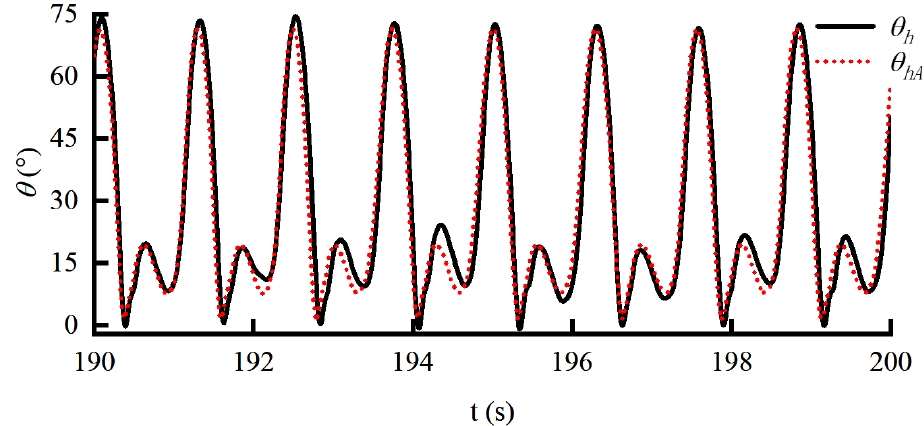
Figure 14. The angle curve predicted by AO.